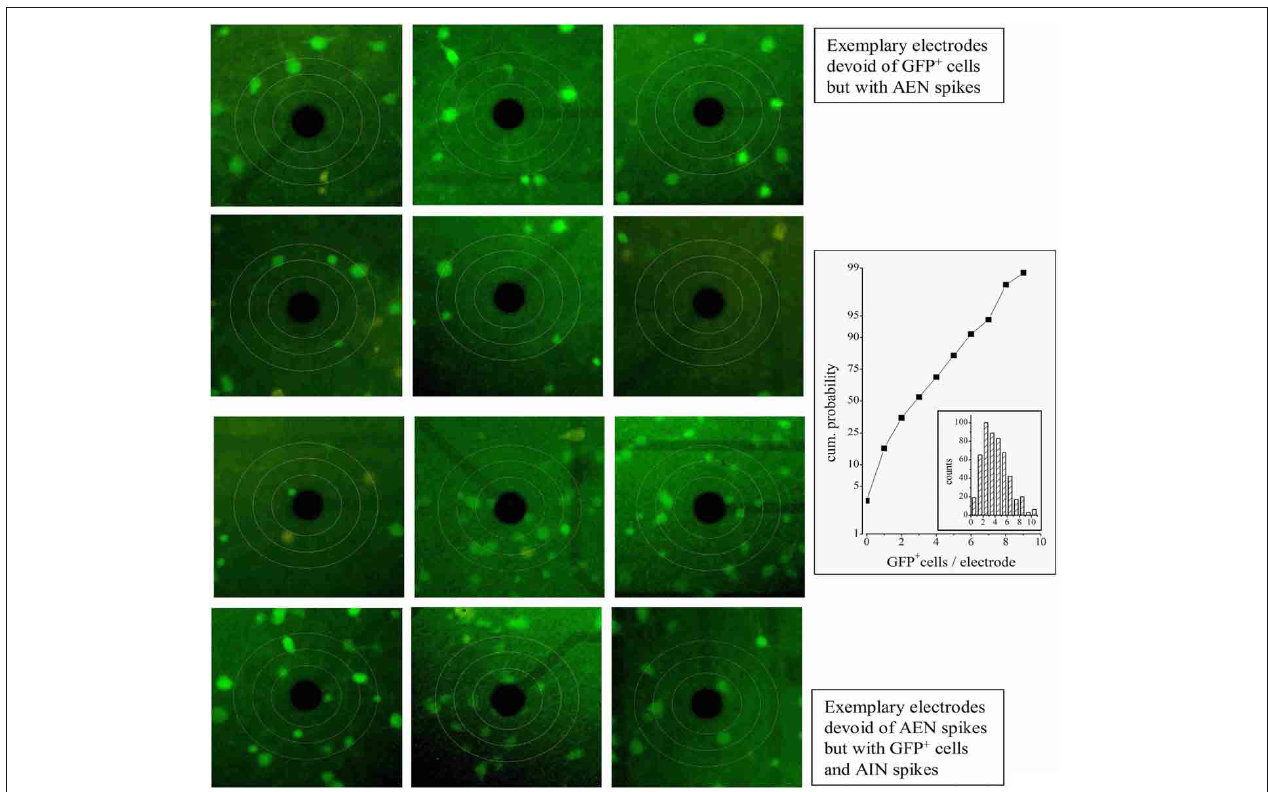
FIGURE 2 | GFP + neurons near MEA electrodes. Three circles were drawn centered on each electrode, with diameters of respectively 70, 110, and 150 μ m. The upper panels show a series of typical electrodes which showed no nearby GFP + cells within 110 μ m. In these cases, all the firing units were found to be of the AEN type. The lower panels show a series